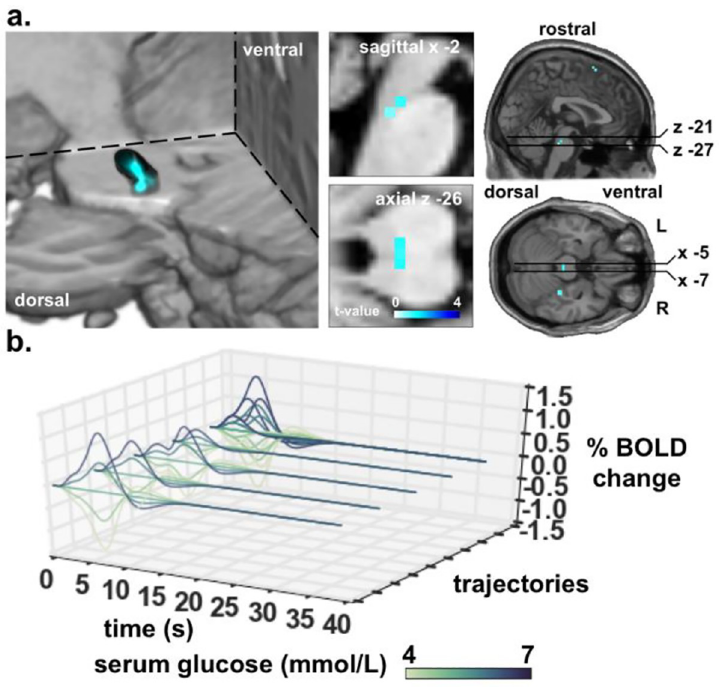
Fig 3. Statistical parametric maps of RPE pos � state and fitted responses over varying glycaemic state. a, main effect of RPE pos � state revealed bilateral activity in the PBN [-2–29–26; FWE SVC]. The colour bar indicates the t-value on a scale of white to blue. b, fitted response ( β = 1.66) of the local maxima of PBN cluster (7 voxels) to the possible trajectories that RPE pos � state , yield (Fig 1D) modulated by serum glucose state. There are four possible trajectories of the positive RPE, according to the four different possible trial types depicted in Fig 1C. These trajectories are modulated by serum glucose and shown as different colours with 5 different equally spaced glycemic states. There are thus 4 sets of these trajectories (the four closest to the viewer), each showing their modulation by glucose in the different colours. In order of closeness to the viewer, the first set of trajectories is for the Cue high - Outcome gluc trial; the second set is for the Cue high − Outcome water trial; the third set is for Cuelow − Outcome gluc trial; the fourth set is for the Cuelow − Outcome water trial. The fifth set of trajectories (furthest from the viewer) superimpose together all possible trajectories depicting the complexity of how the trajectories are patterned according to their modulation by glucose state. For comparison, this presentation is analogous to the superimposed trajectories shown in Fig 1D. Note that the colour bar for the graphs in (b) is serum glucose and is distinct from the colour bar in (a) used to indicate t-values.